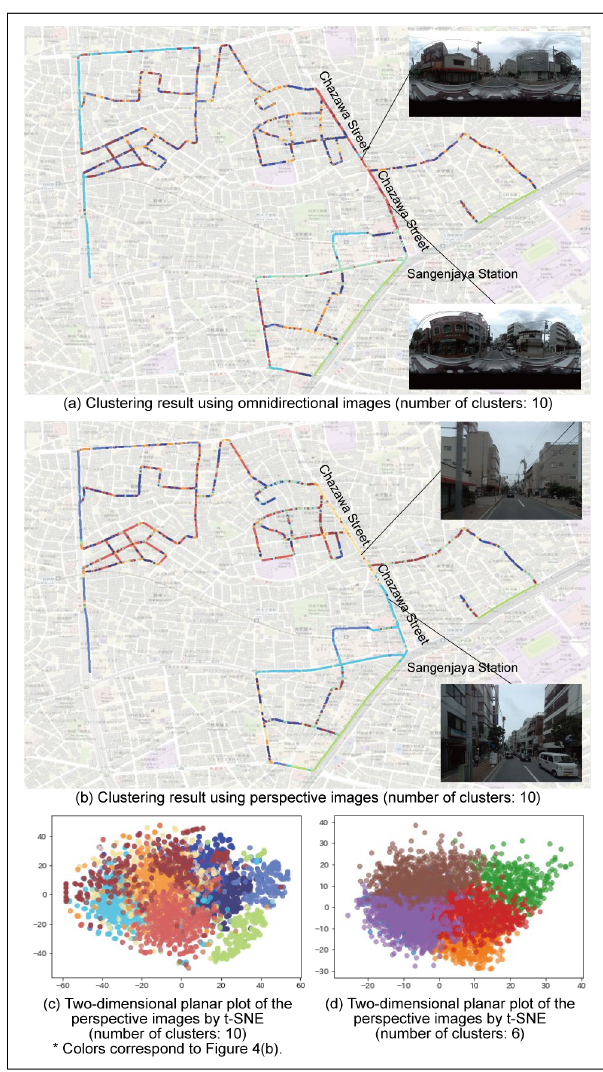
Figure 4. Comparison of clustering results using different type of images in the same region.